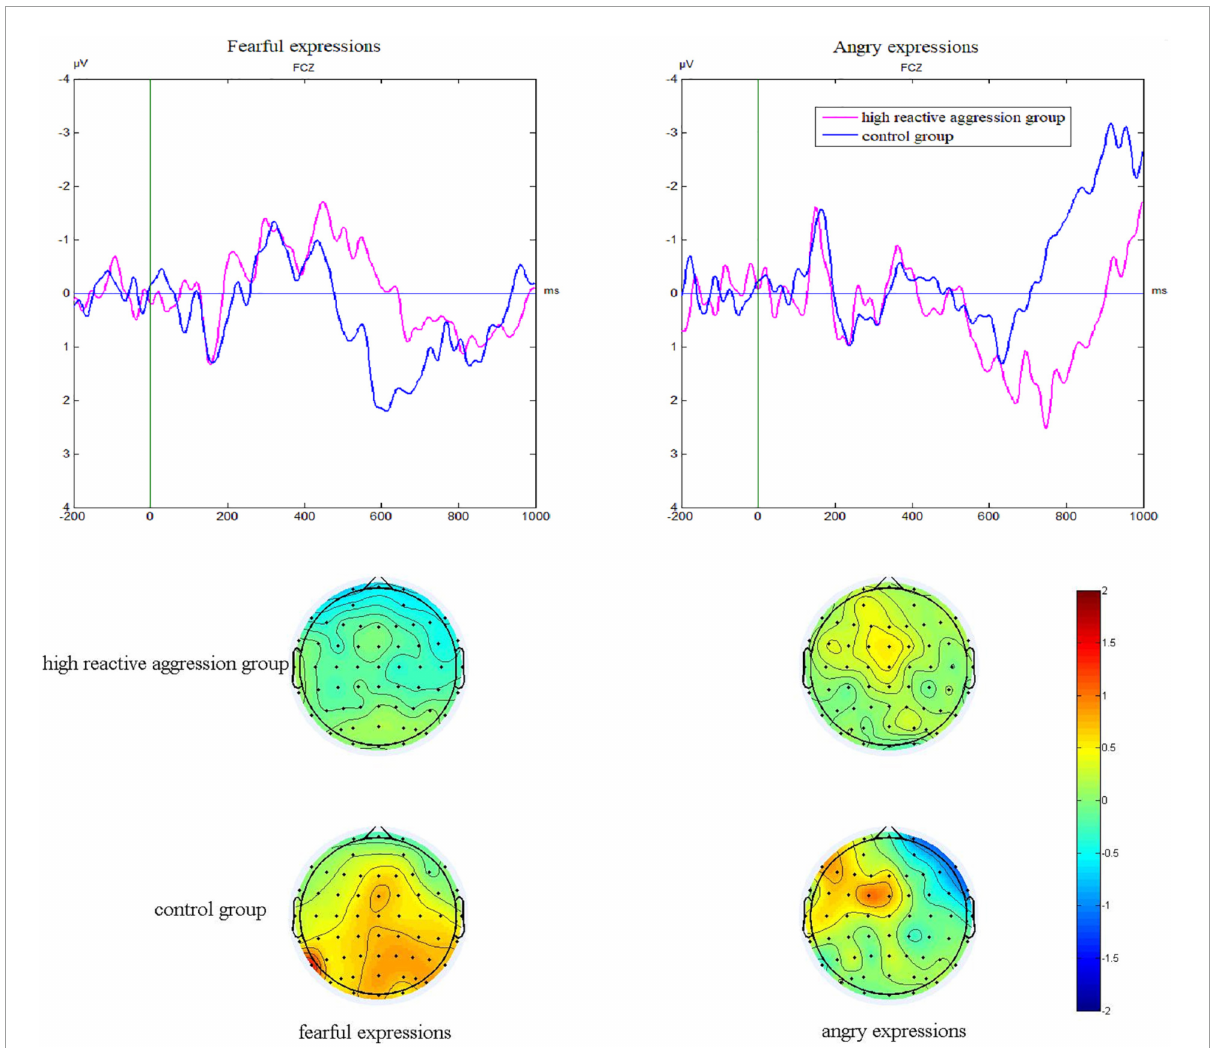
FIGURE3 P3 difference waves of No-Go subtracted from Go trials at the FCz site and corresponding scalp topography at 580–650 ms of the two groups in fear and anger